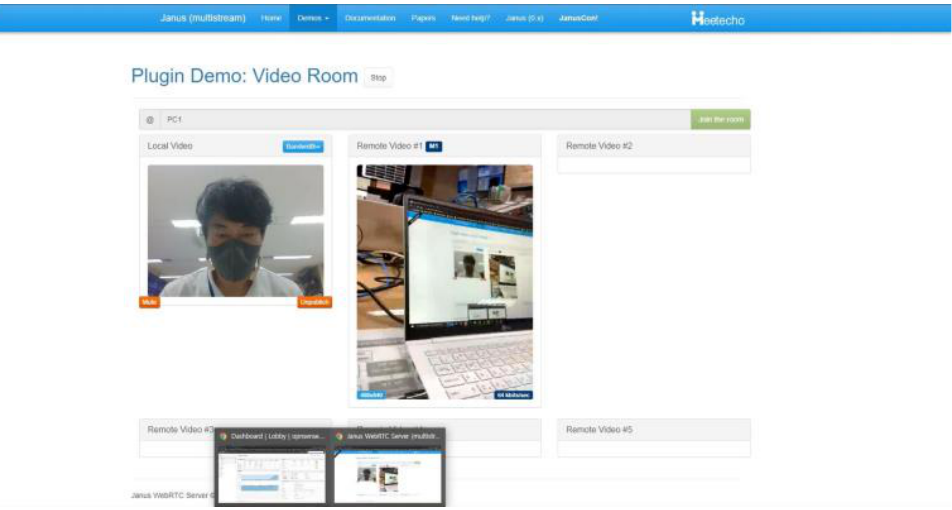
Figure 13. Experiment outcome of test scenario 2 (Chrome browser screenshot of the video room through Web-RTC server (Janus)).